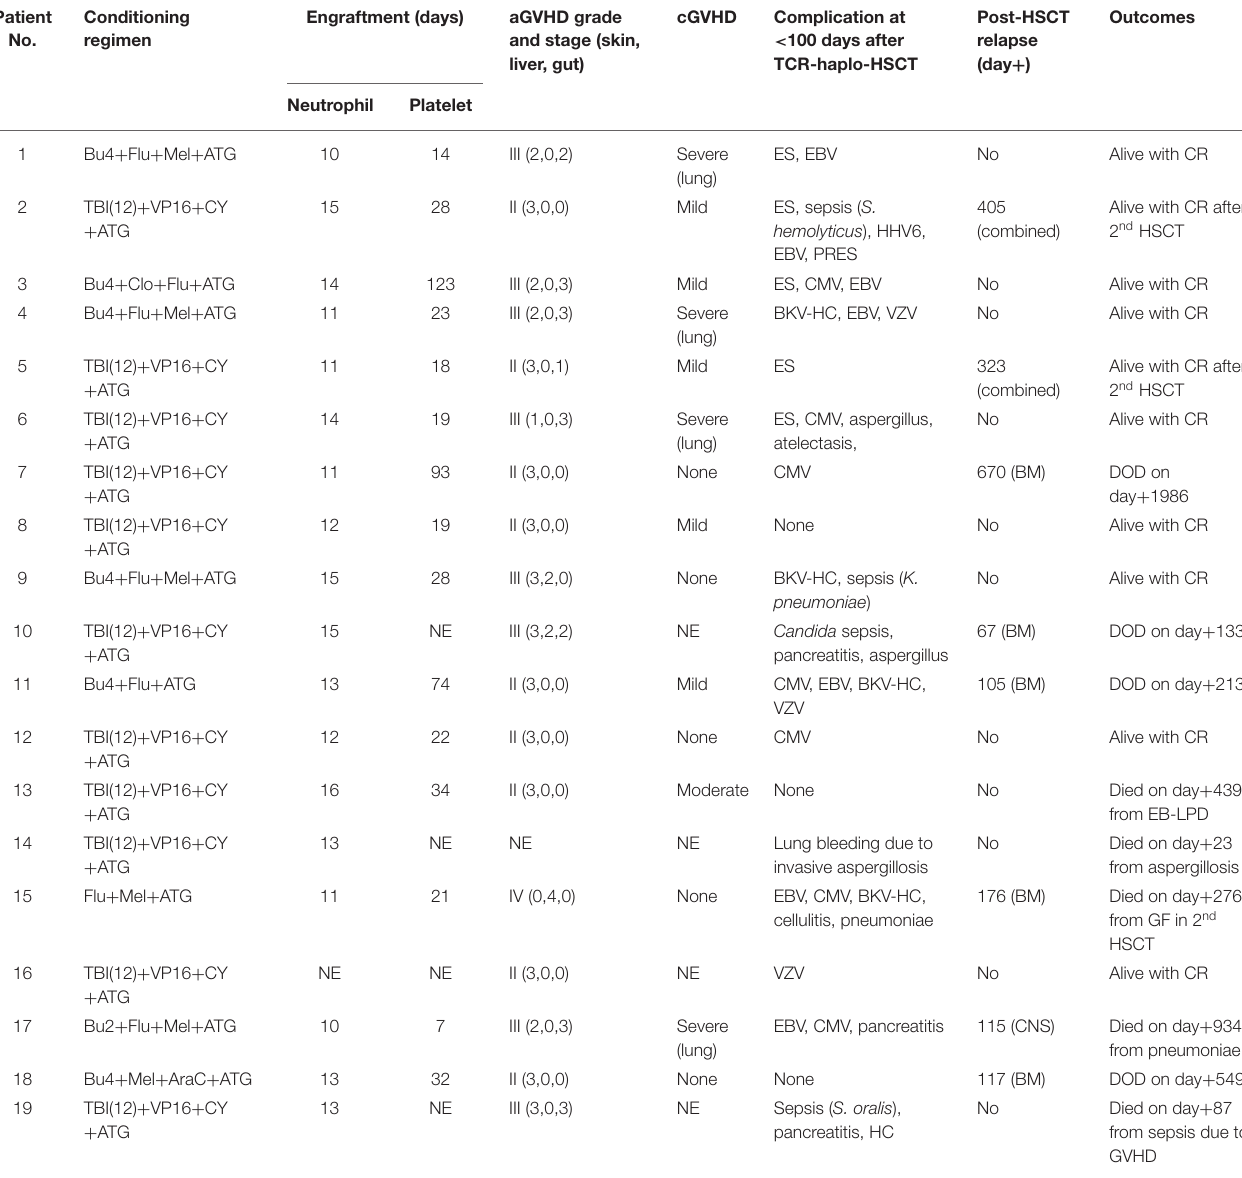
TABLE 2 | T-cell replete haploidentical stem cell transplantation and clinical outcomes. Patient No.